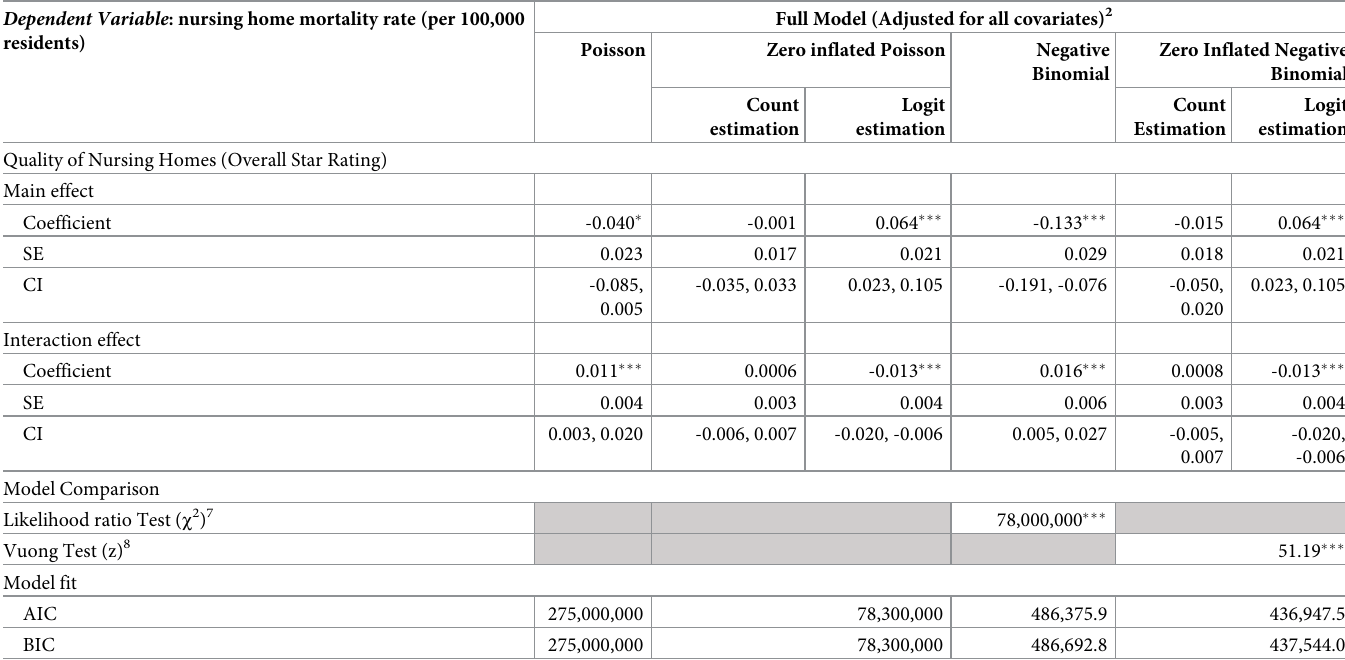
Table 3. Multivariable regression results–role of nursing home quality, full